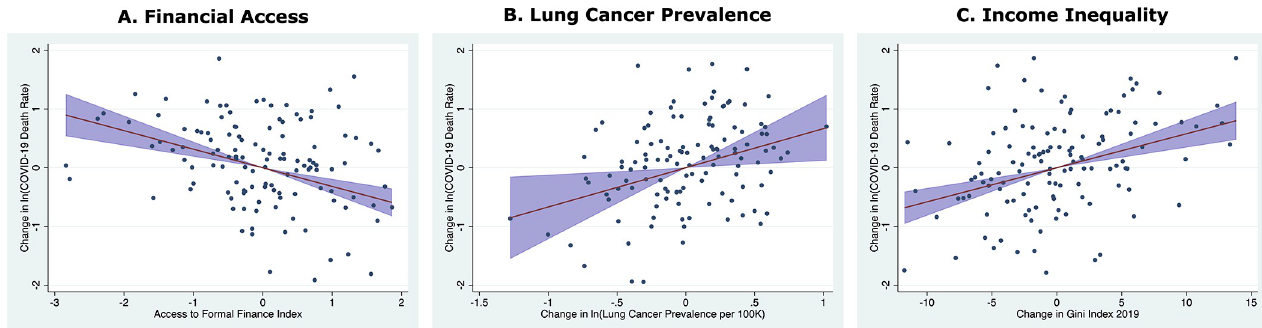
Fig 1. Comparing conditional partial correlation of COVID-19 mortality with financial access, lung cancer, and income inequality. (A) Conditional partial correlation of national COVID-19 mortality with pre-COVID-19 Index of access to formal finance; 95% confidence interval shaded. (B) Similar, with pre-COVID-19 ln(average lung cancer incidence rate, age-standardized per 100,000, male & female, all ages). (C) Similar, with pre-COVID Gini index of income inequality.